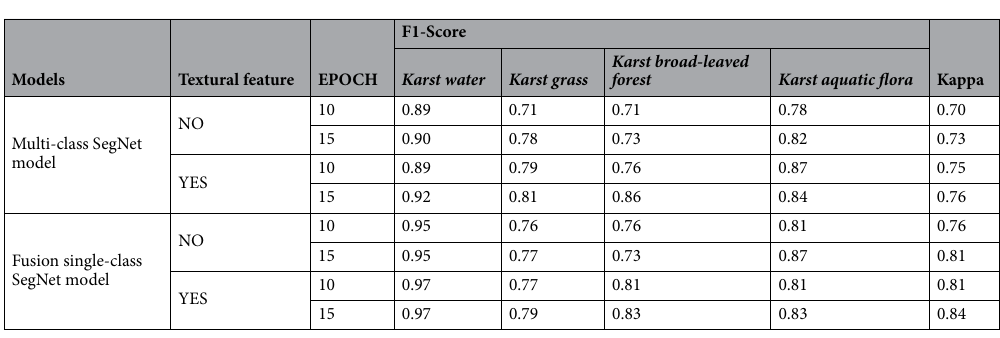
Table 6. The classification accuracies of multi-class SegNet models with textural features and different EPOCH values.